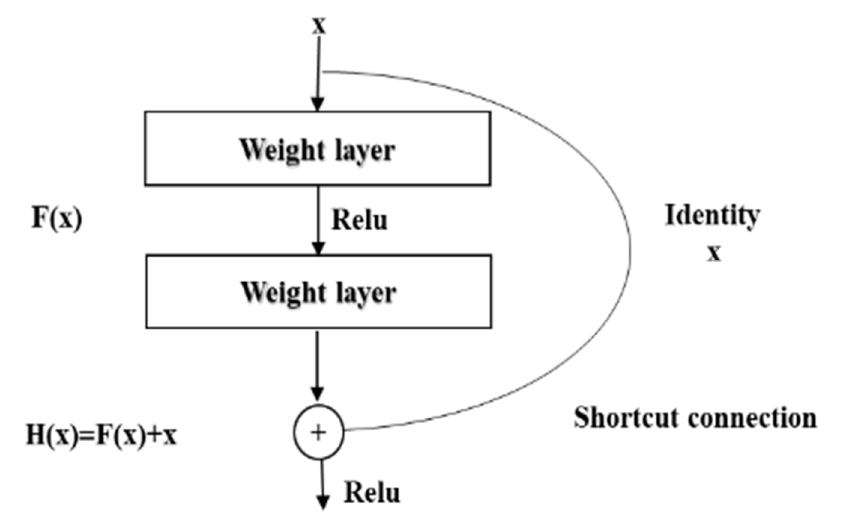
Figure 1. The residual block of the residual network.